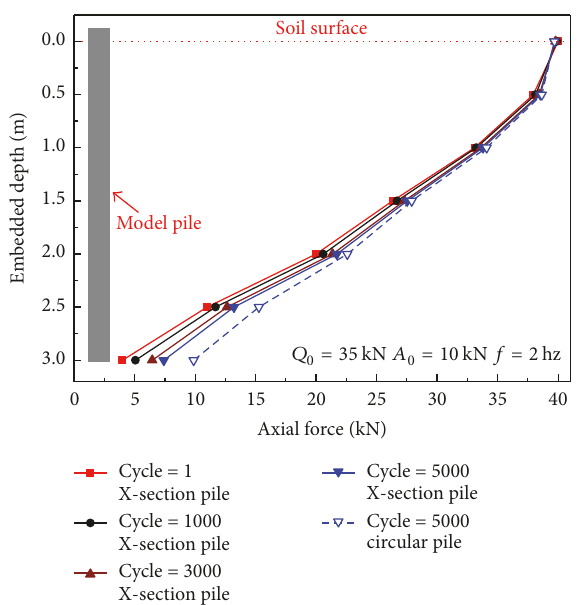
Figure 10: Distributions of axial